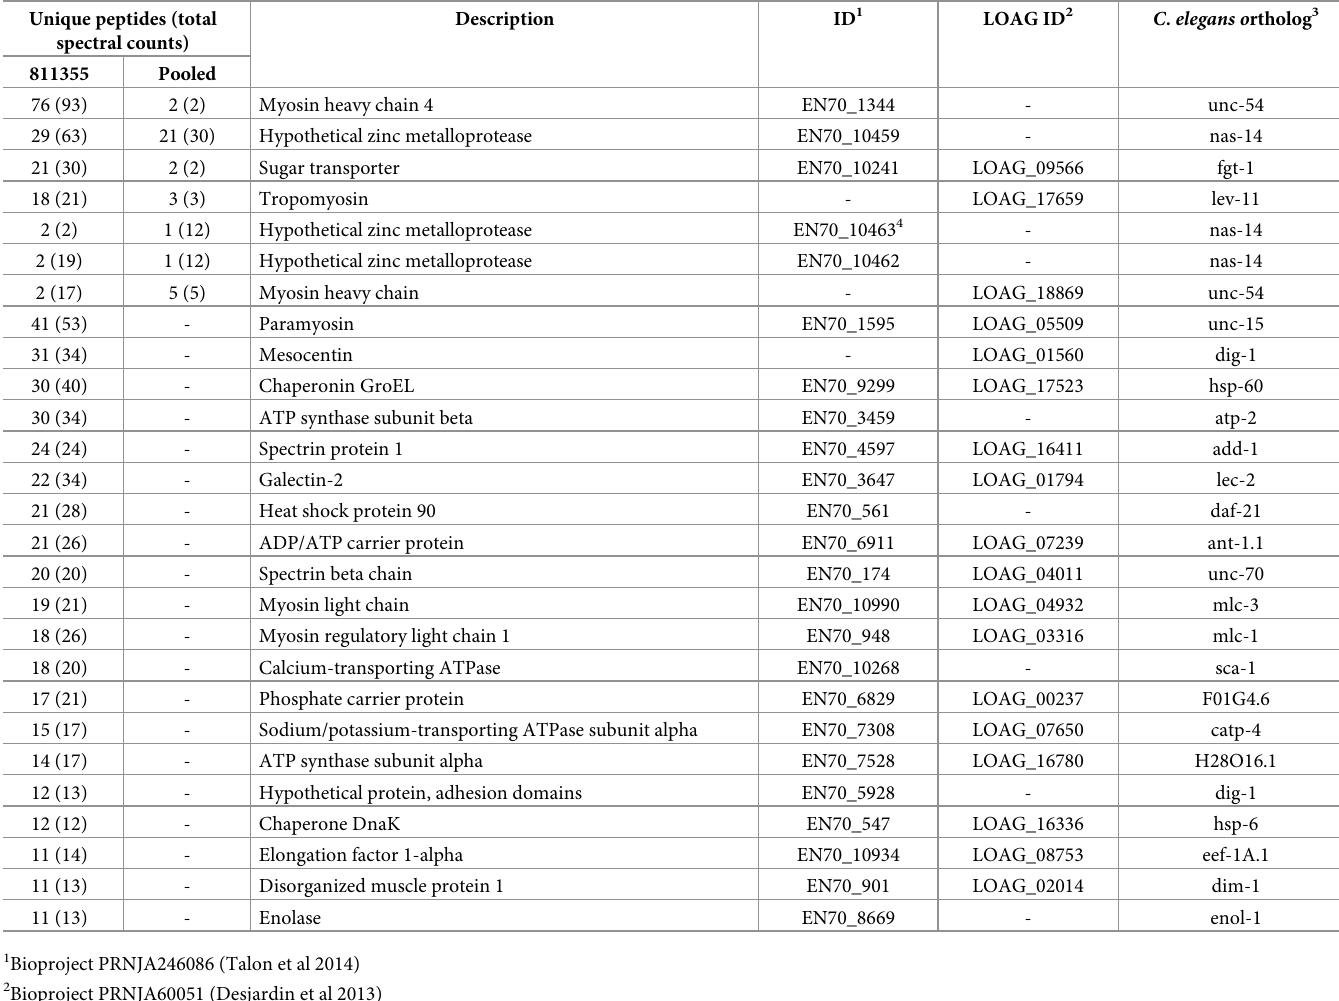
Table 3. Proteins identified in cross-reactive L . loa sera. Unique peptides (total spectral